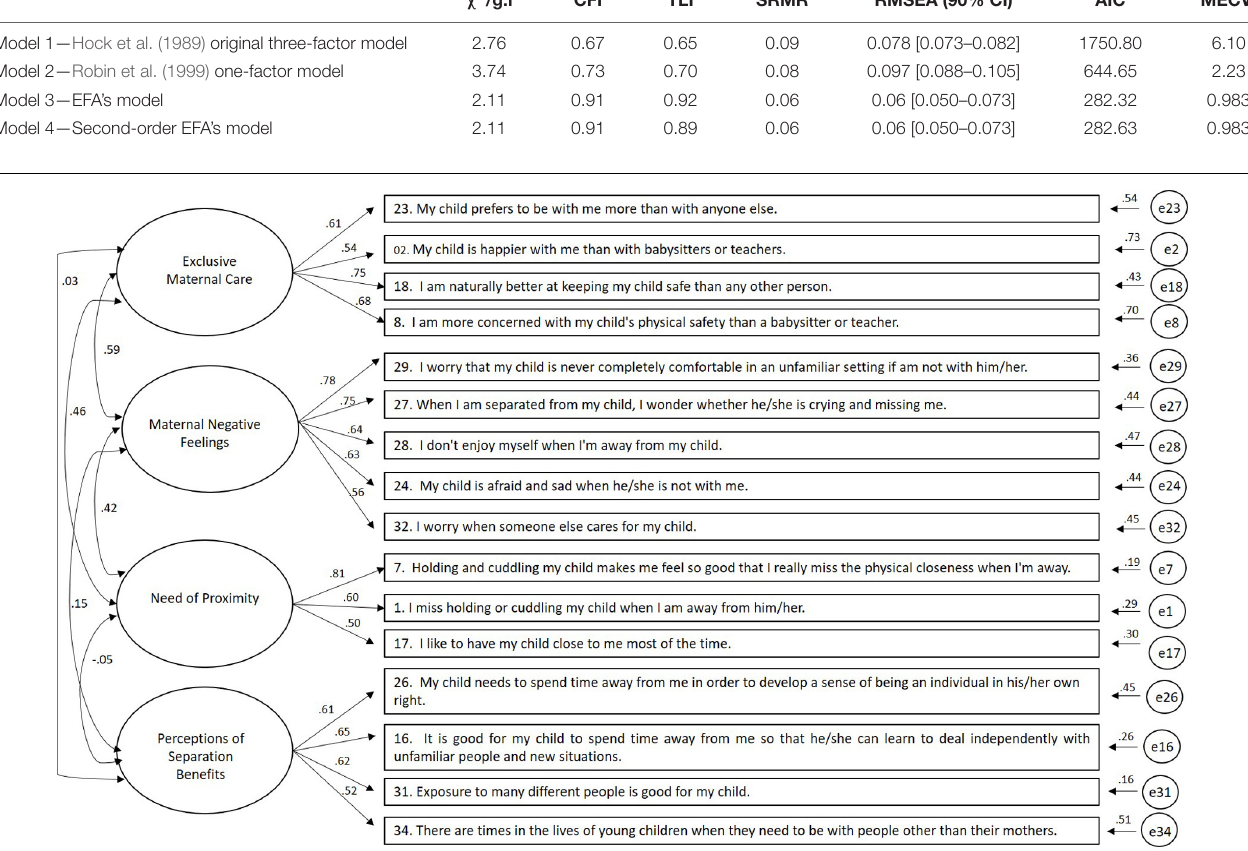
TABLE 4 | Goodness-of-fit indexes of confirmatory factor analyses in subsample 2 ( n = 293) comparing Hock et al. (1989) original three-factor model, Robin et al. (1999) one-factor model, and EFA’s four-factor model. χ 2 /g.l